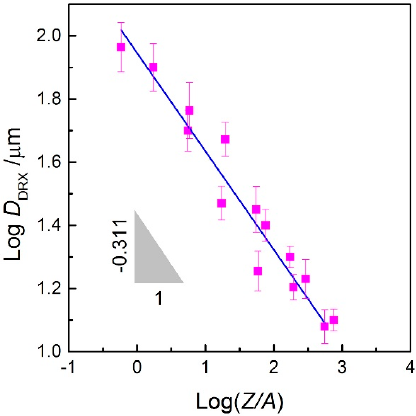
Figure 16. Correlation between log D DRX vs. log( Z / A ) at various deformation conditions.